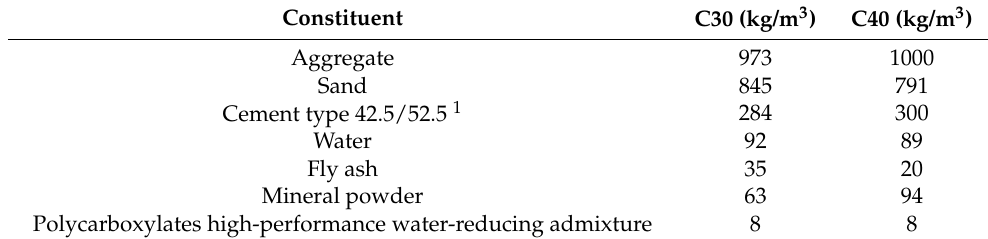
Table 1. Mix design for